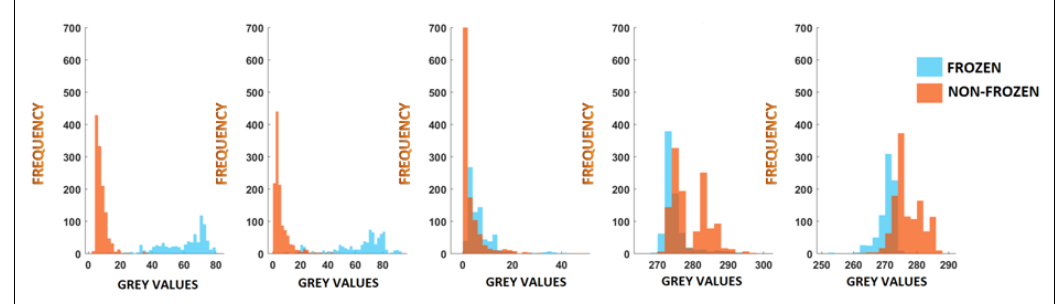
Figure 5: Grey-value histograms of all VIIRS channels (from left to right : I 1 , I 2 , I 3 , I 4 , I 5 ) for lake Sihl. Non-frozen data is from images in October 2016 and first half of December 2016 . Frozen data refers to images from February 2017 . Best viewed on screen. Feature Vector